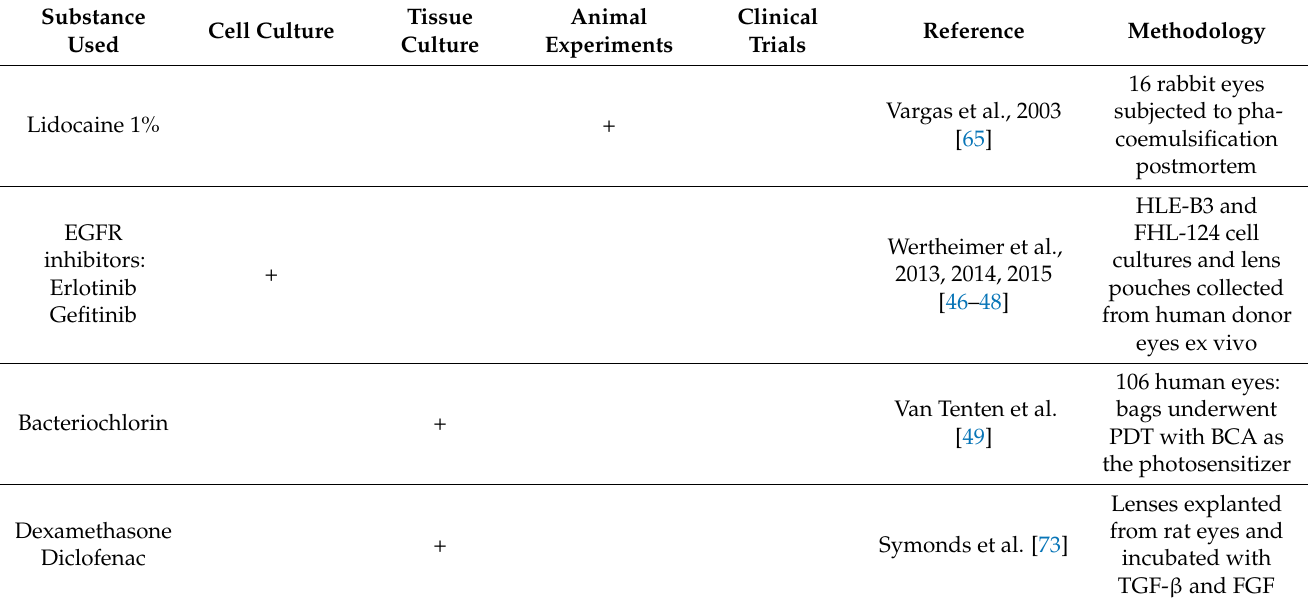
Table 1. Clinical research for